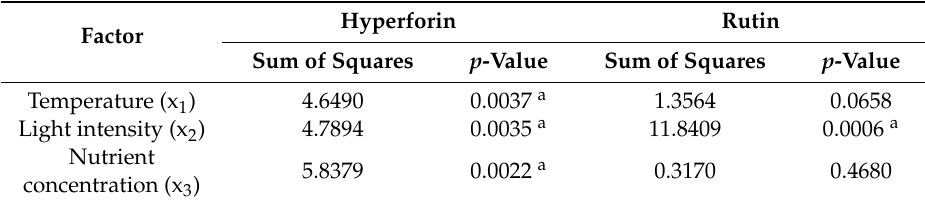
Figure 3. The relationship between predicted and experimental contents of ( a ) hyperforin and ( b ) rutin. Table 3. Analysis of variance for joint